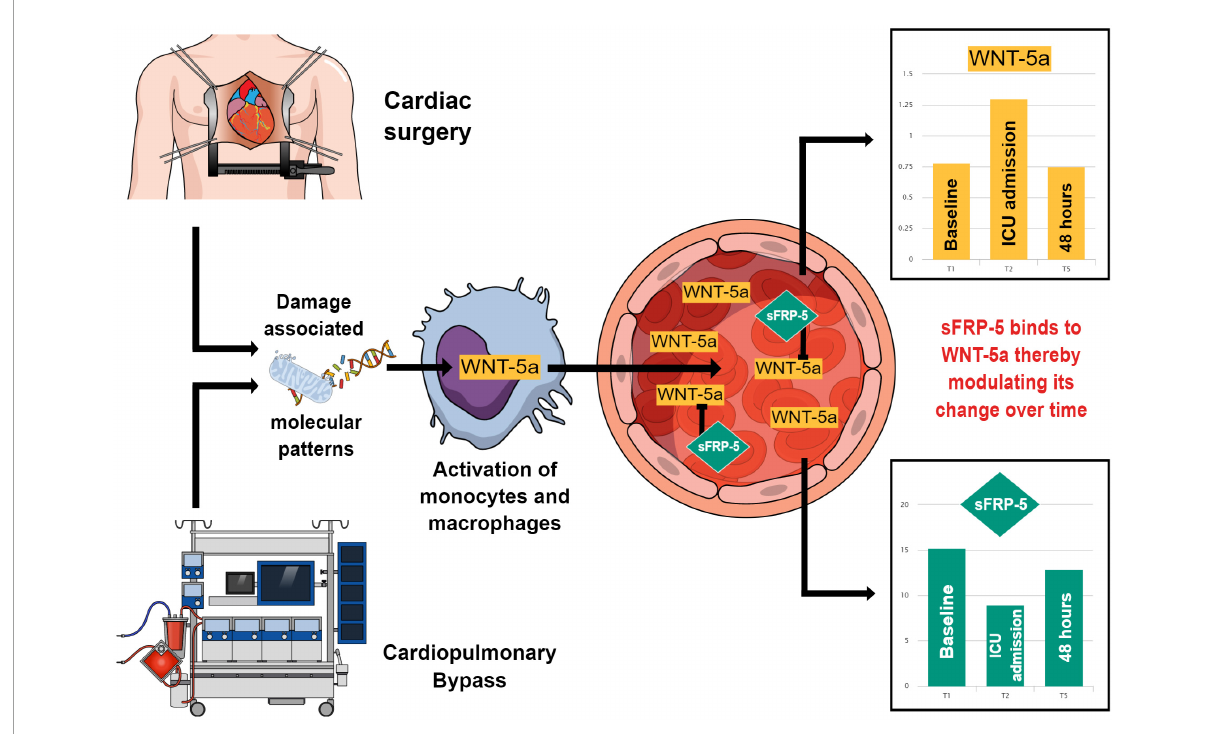
FIGURE6 This figure summarizes how Wingless-related integration site 5a (WNT-5a) may come into play in a systemic inflammation caused by cardiac surgery and how its plasma concentration may be modulated by Secreted frizzled-related protein 5 (sFRP-5). Cardiac surgery and the use of cardiopulmonary bypass lead to the formation of damage associated molecular patterns which activate cells of the mononuclear phagocyte system. These cells produce and secrete WNT-5a which enters the circulatory system. In the blood stream, WNT-5a is bound by its antagonist sFRP-5 forming a soluble complex. Between the baseline (T1), the time of intensive care unit (ICU) admission (T2) and 48 h after surgery (T5), the blood plasma concentrations of WNT-5a and sFRP-5 move in the opposite direction compared to each other. This may demonstrate the modulatory effect of sFRP-5 on the WNT-5a plasma concentration leading to an attenuation of the WNT-5a peak value during the promotion of a systemic inflammation upon cardiac surgery and a timely return of WNT-5a to its baseline value during the resolution of the inflammatory